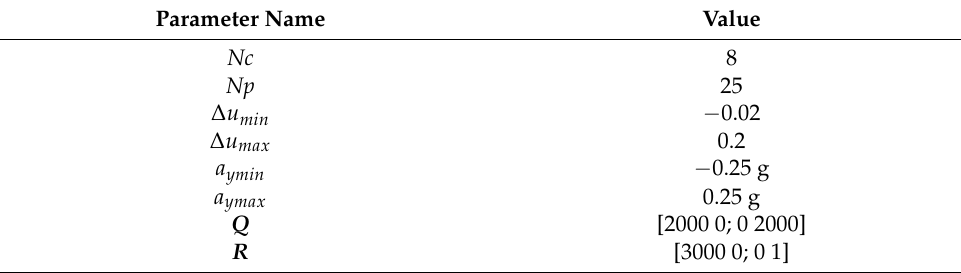
Table 1. Part of the parameter settings of the